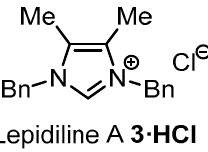
Figure 2. Naturally-occurring imidazolium salt Lepidiline A 3·HCl .